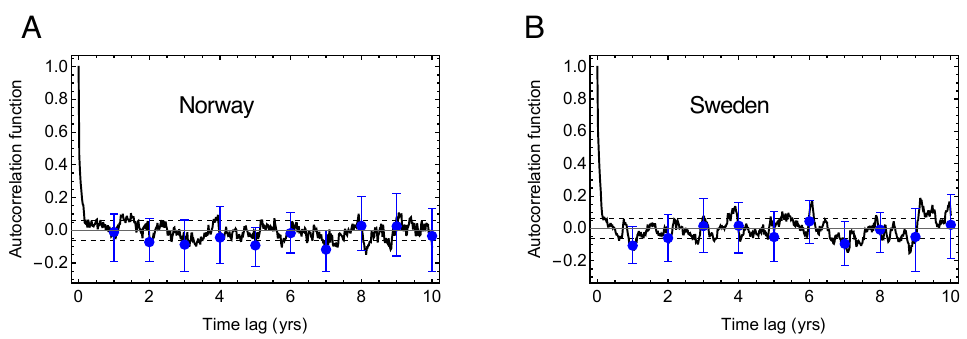
Figure 3. Auto-correlation function of the excess mortality signal. ( A ) The black curve shows the autocorrelation function estimated from the weekly excess mortality in Norway. The dashed lines indicate the 95% confidence interval under the assumption of uncorrelated data. The blue points show the autocorrelation function estimated from yearly excess mortality, and the blue error bars show the spread between the correlations estimated using different weeks of each year. ( B ) As in ( A ), but for